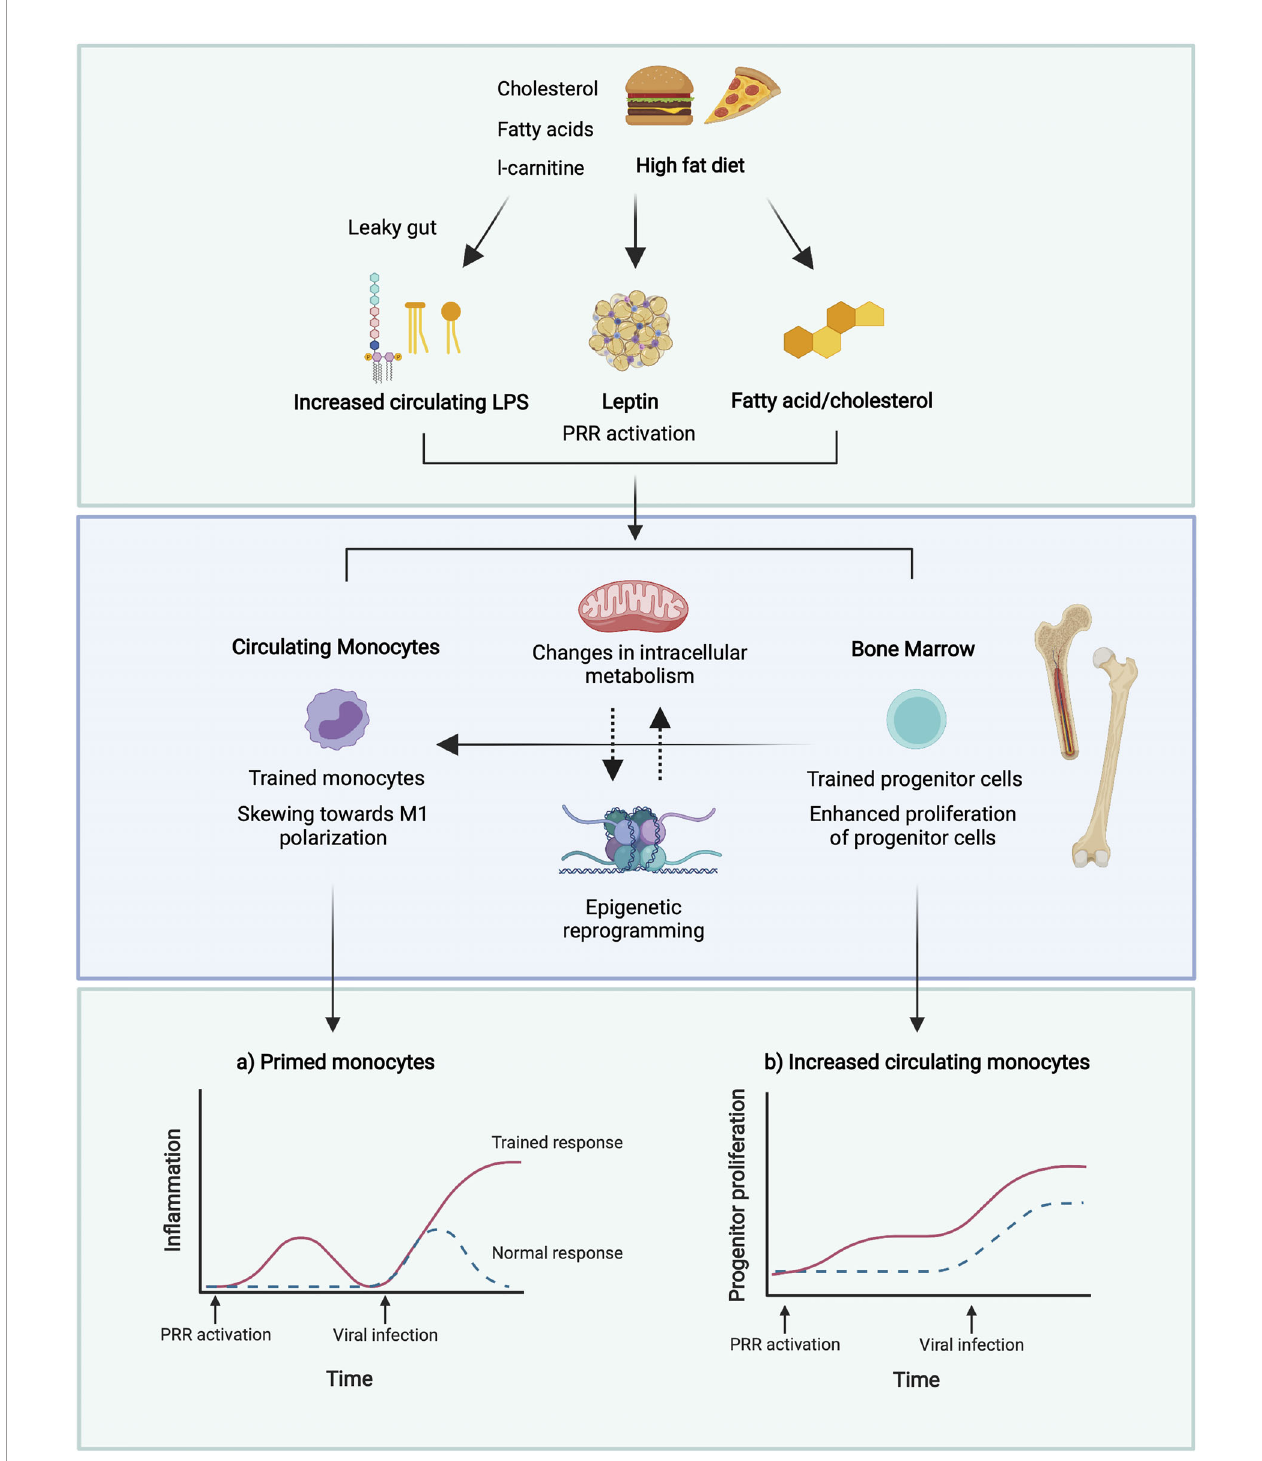
FIGURE 2 | Potential mechanisms of induction of trained immunity in obesity. A leaky gut following a high dietary fat intake results in increased circulating levels of LPS (229) which may induce trained immunity (238, 239). High glucose conditions may boost immune training in monocytes and enhance the proliferation of HSPCs in the bone marrow (235). Reduced adiponectin in obesity may promote polarisation towards M1 macrophages and defective HSPC proliferation (240, 241), whilst increased leptin may promote proliferation and activation of circulating monocytes and BM myelopoiesis (242, 243). This may result in enhanced monocyte populations, and enhanced pro-in fl ammatory responses of these monocytes to viral infection. Figure created with